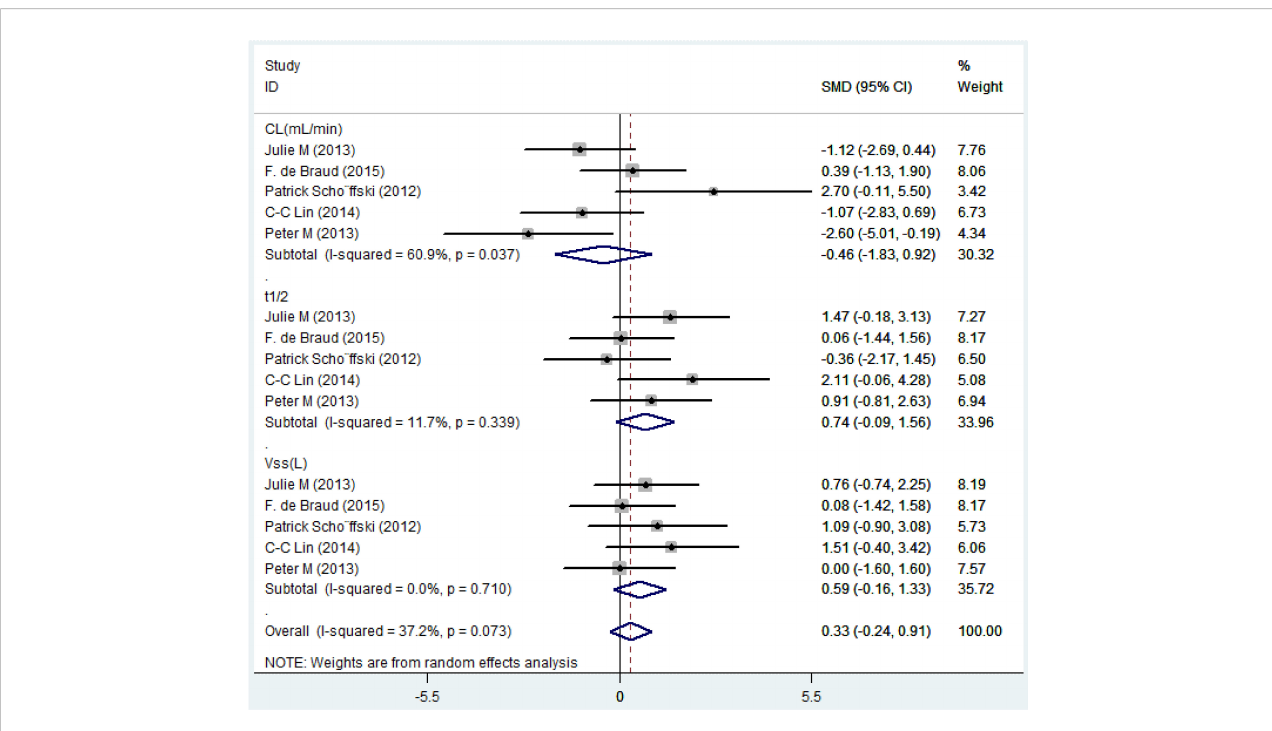
FIGURE 4 Forest plots of the pooled SMD for pharmacokinetic parameter by overall